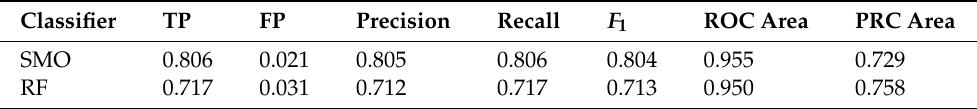
Table 10. Comparison of SVM and Random Forest (RF) classifiers on the HeLa data set.